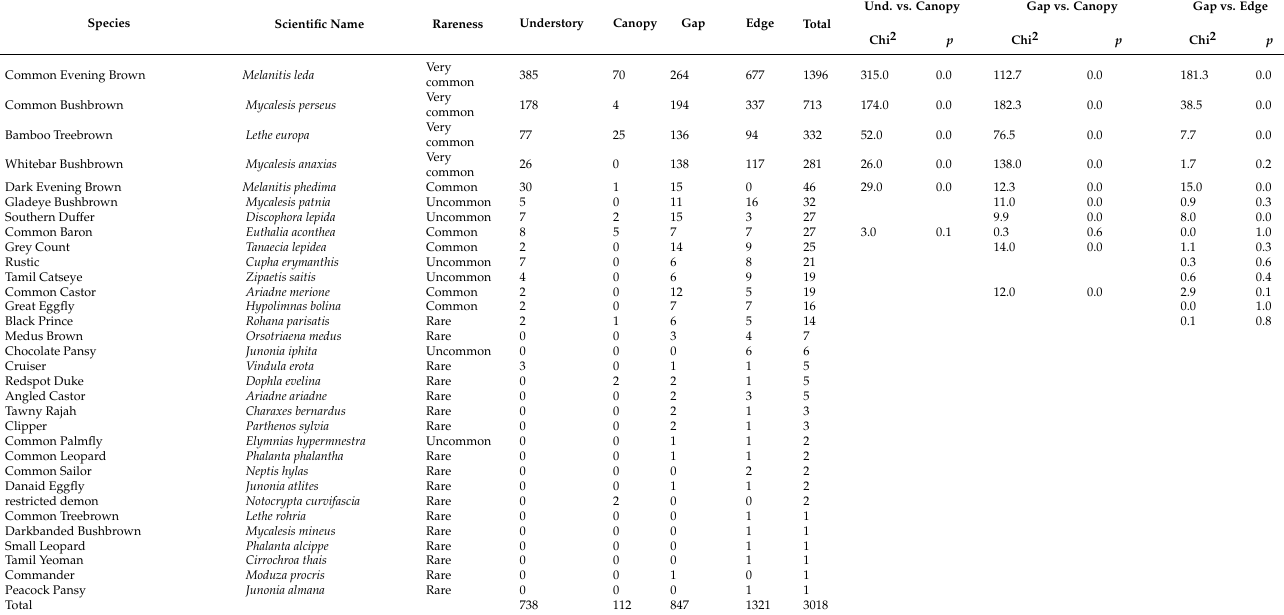
Table 2. Butterflies recorded from fruit-baited traps in the four principal habitats in the Silent Valley National Park of the Western Ghats, India.